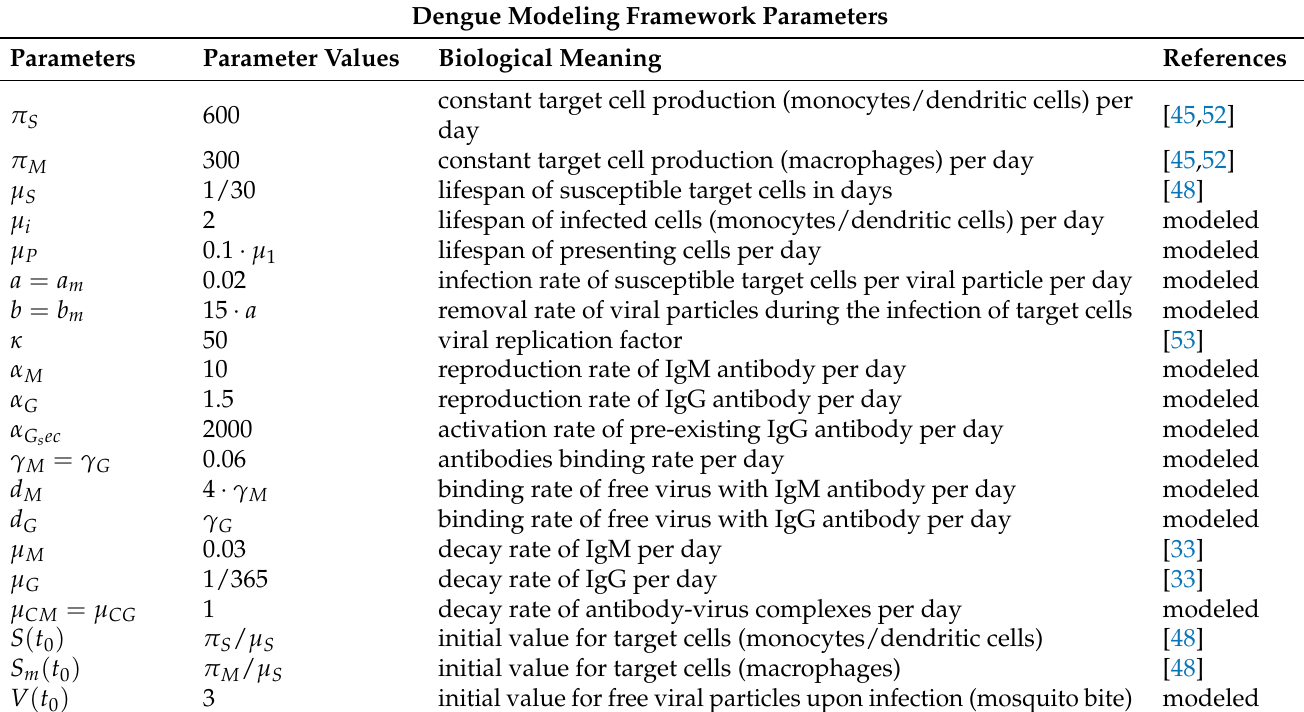
Table 1. The biological meaning of the parameters and parameter values used for the numerical